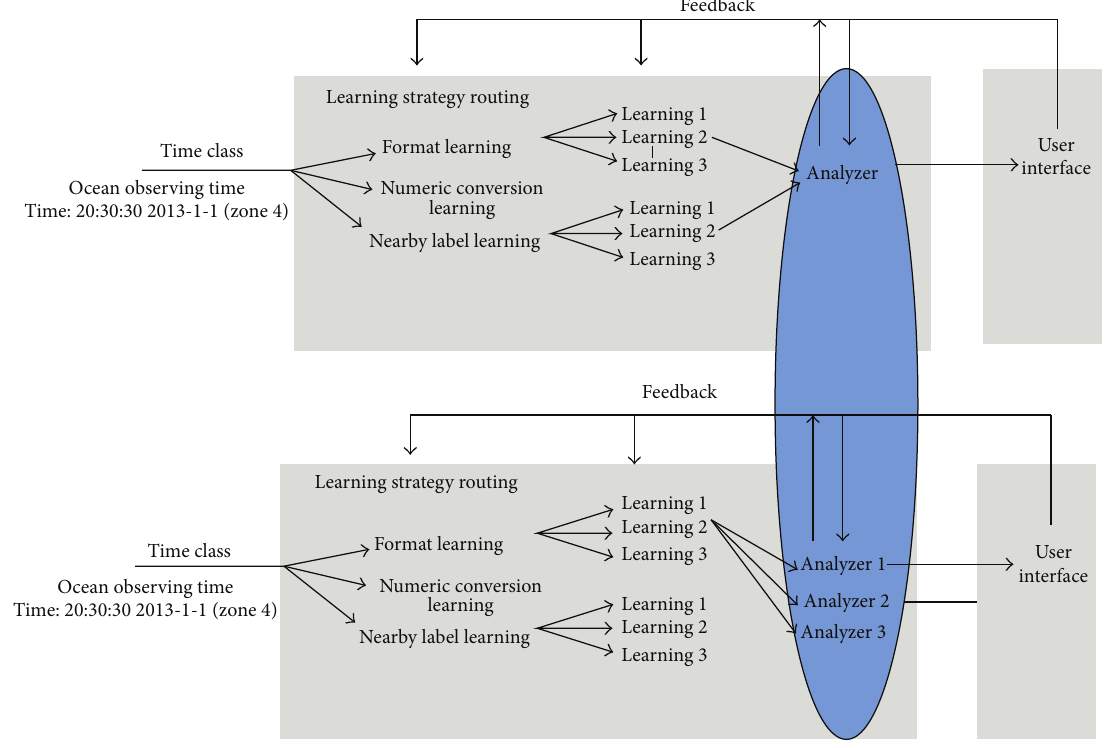
Figure 5: Multianalyzer automatic schema mapping